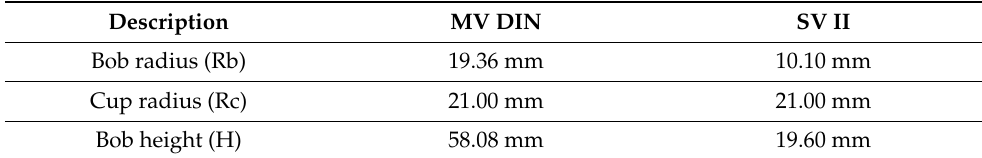
Figure 3. Schematic representation of cup and bob viscometer. Table 5. Cup and bob dimensions.